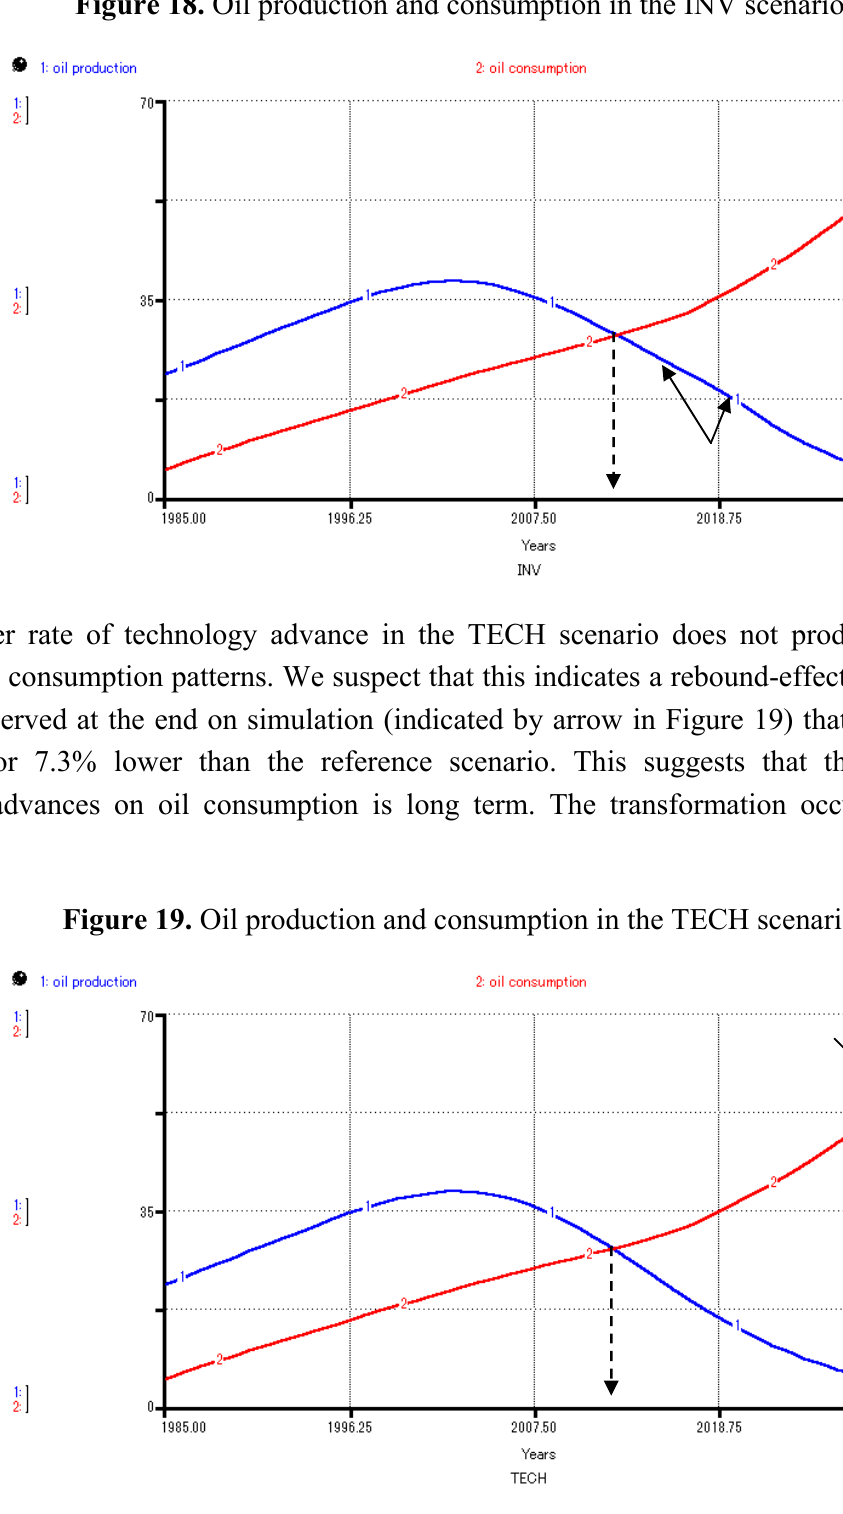
Figure 18. Oil production and consumption in the INV scenario.